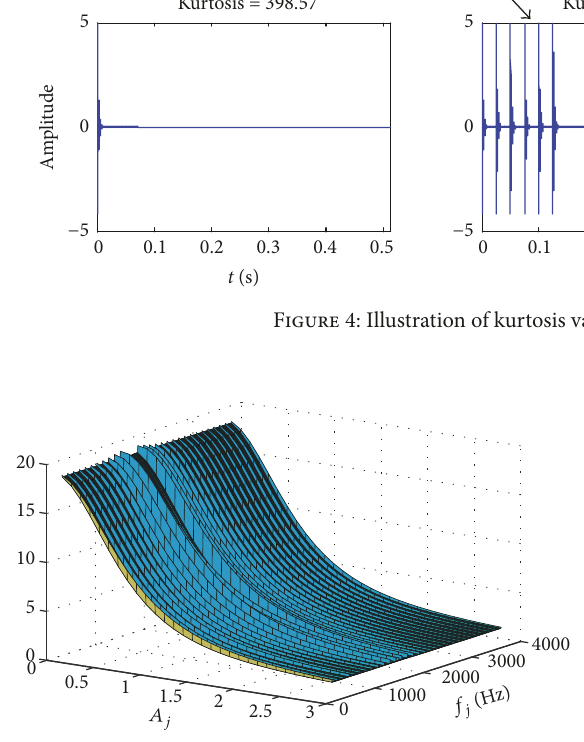
Figure 5: Illustration of the kurtosis values of the signal expressed by (11).